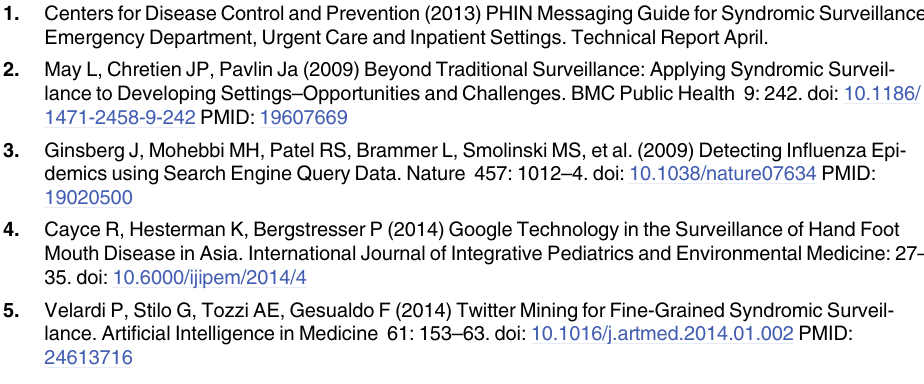
S2 Fig. Histogram of participating household sizes. Used for the calculation of proportion of ‘ others-sick ’ as in Fig